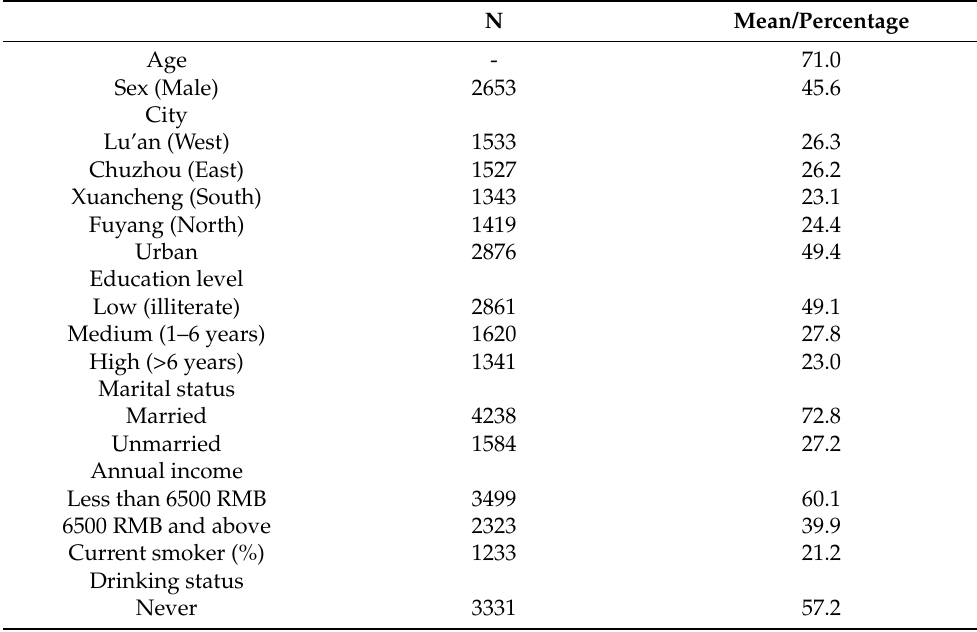
Table 1. Basic characteristics of the enrolled